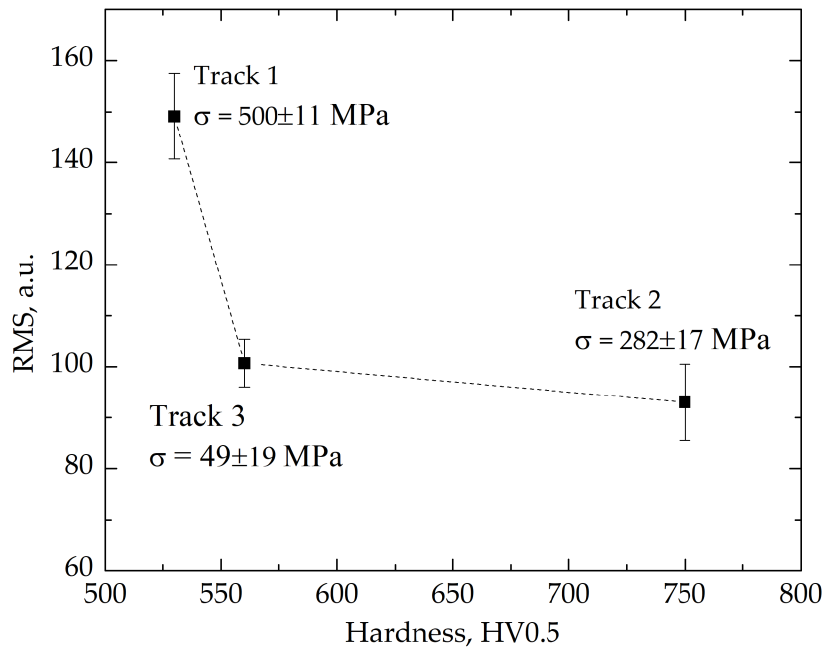
Figure 13. The dependence of the average RMS value, measured in the center of the track, on hardness and residual stresses.